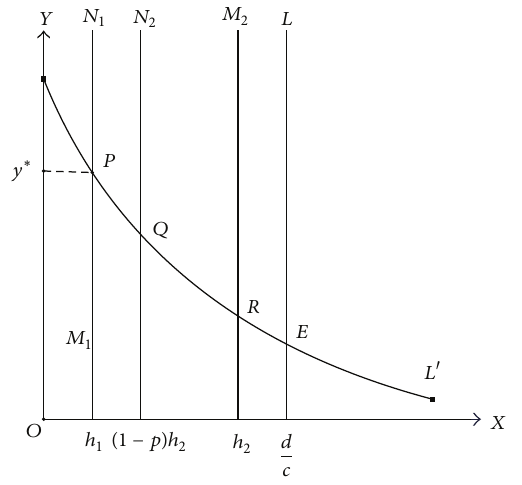
Figure 5: The orbit starting from the point 𝐶 0 (Case 2 in Section